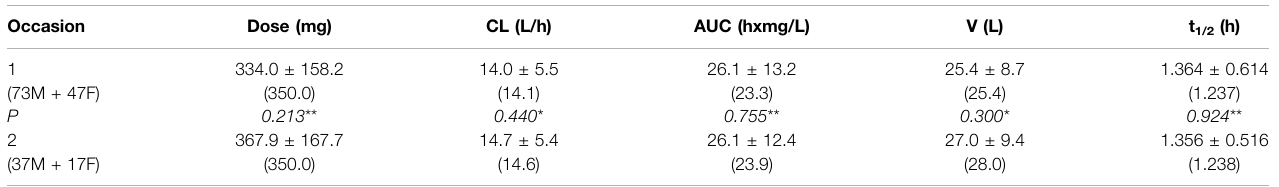
TABLE 4 | Pharmacokinetics of ACV across two occasions. Values are presented as mean ± SD (median)